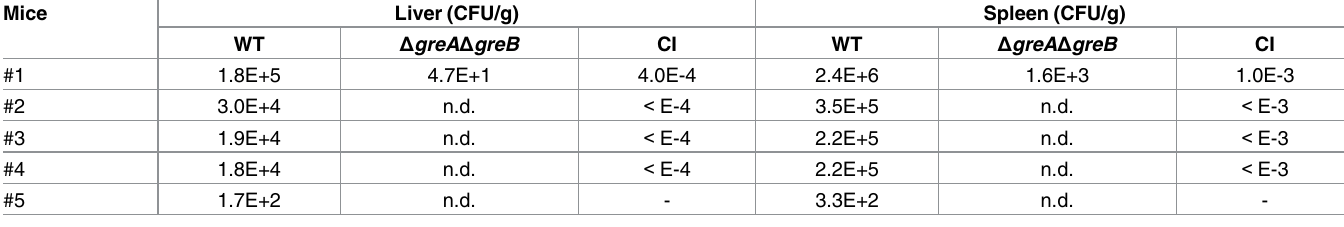
Table 1. Competition assayof the Δ greA Δ greB mutant strain versus WT. Amount of bacteriain liver and spleenwas determined at 4 days post infection. A total of ~2E+7 colony forming units (cfu) of WT and the Δ greA Δ greB strain at a 1:1 ratio was administeredorallyto 5 mice. Mice Liver (CFU/g) Spleen (CFU/g) WT Δ greA Δ greB CI WT Δ greA Δ greB CI #1 1.8E+5 4.7E+1 4.0E-4 2.4E+6 1.6E+3 1.0E-3 #2 3.0E+4 n.d. n.d. #3 1.9E+4 1.8E+4 1.7E+2 n.d. n.d. n.d.: